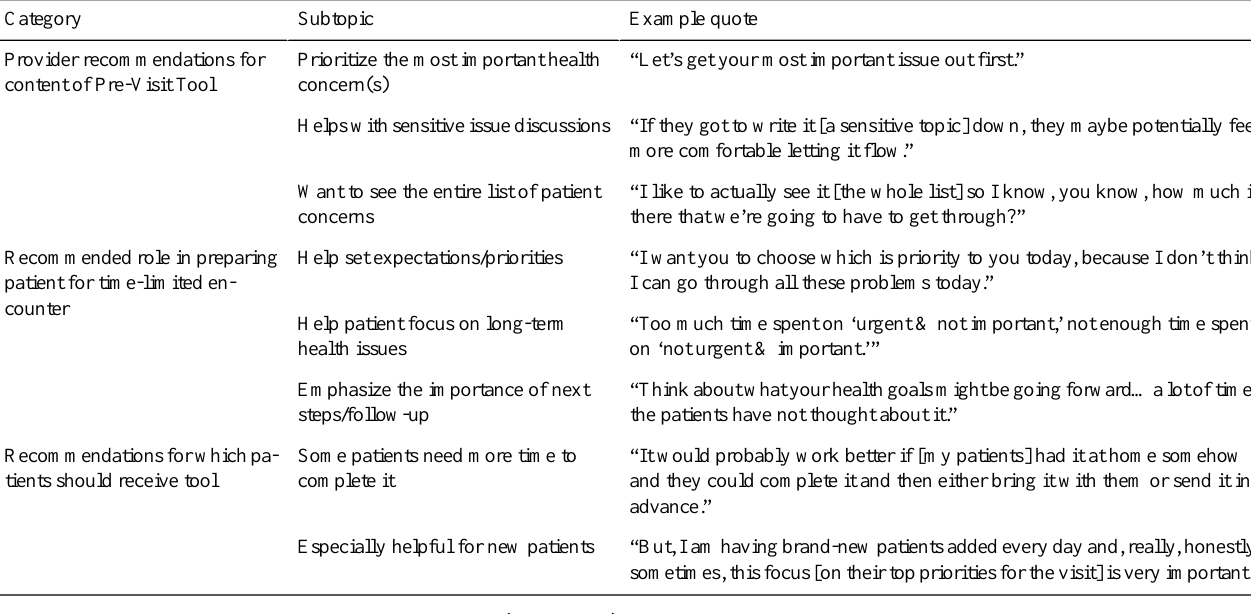
Table 2. Provider interview findings.